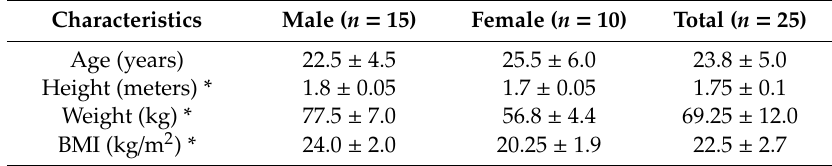
Table 1. Participants’ socio-demographic